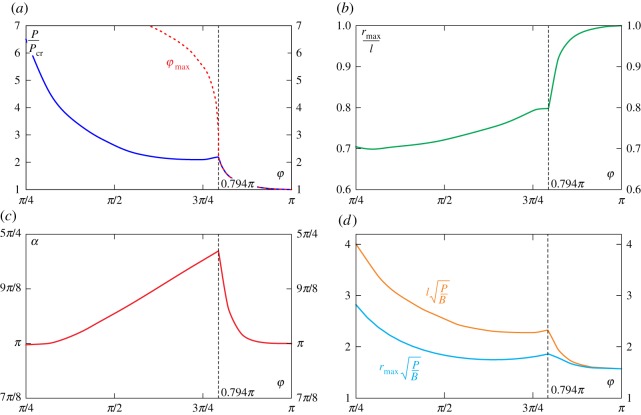
Optimal load ratio P/Pcr as a function of the polar coordinate φ for which equation (5.3) is maximized (a). Maximum radial distance rmax normalized through division by the length l (b) and corresponding clamp inclination α (c) as functions of the angle φ. Arm length l and the maximum radial distance rmax (made dimensionless through division by the fixed parameters P and B) at varying the polar angle φ (d). (Online version in colour.)